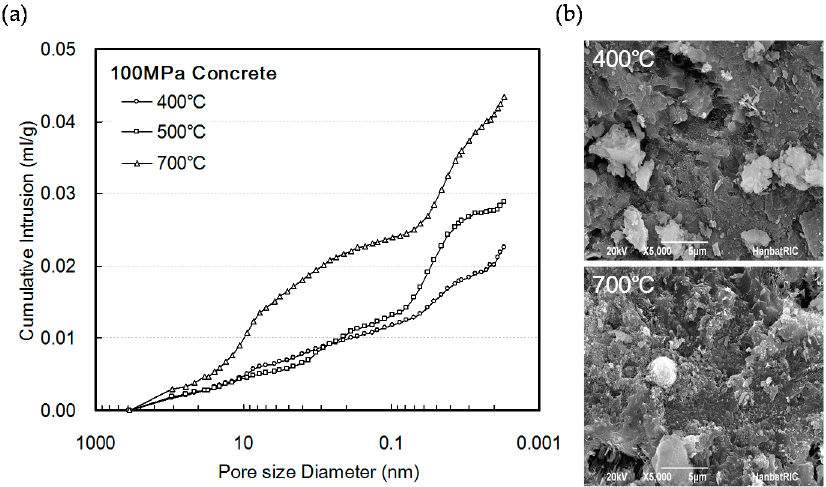
Figure 7. Pore volume and scanning electron microscope image of 100 MPa concrete according to heating temperature: ( a ) cumulative pore volume; ( b ) scanning electron microscope image.